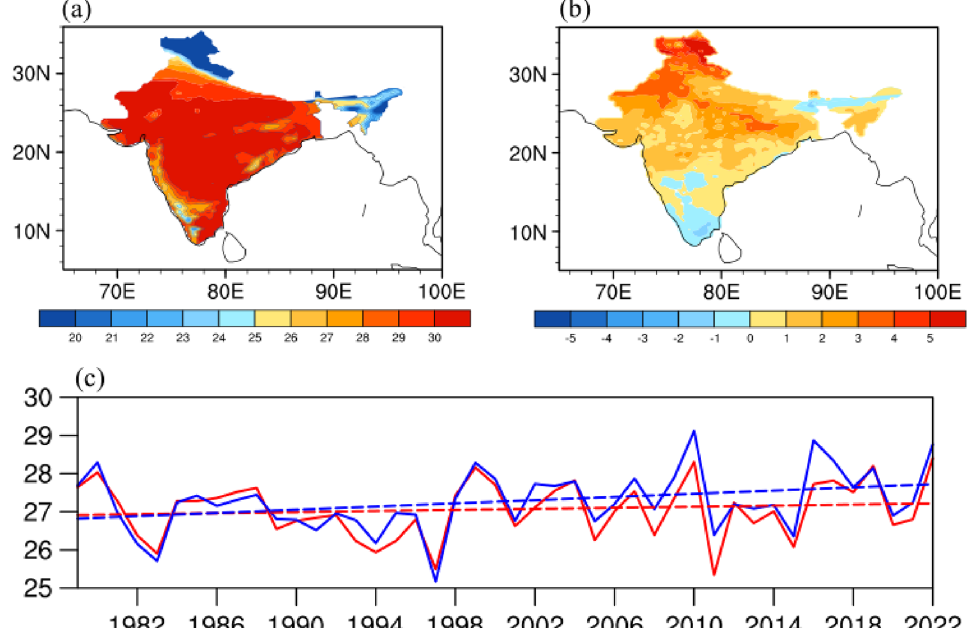
Fig. 1 a The climatological mean of surface air temperature (SAT; °C) over the Indian continent during April for the period of 1979–2022. b The SAT anomalies over the Indian continent during April 2022. c The SAT averaged in the Indian continent (the SATI; solid lines) companied with the trend (dashed lines), obtained from NCEP (red) and ERA5